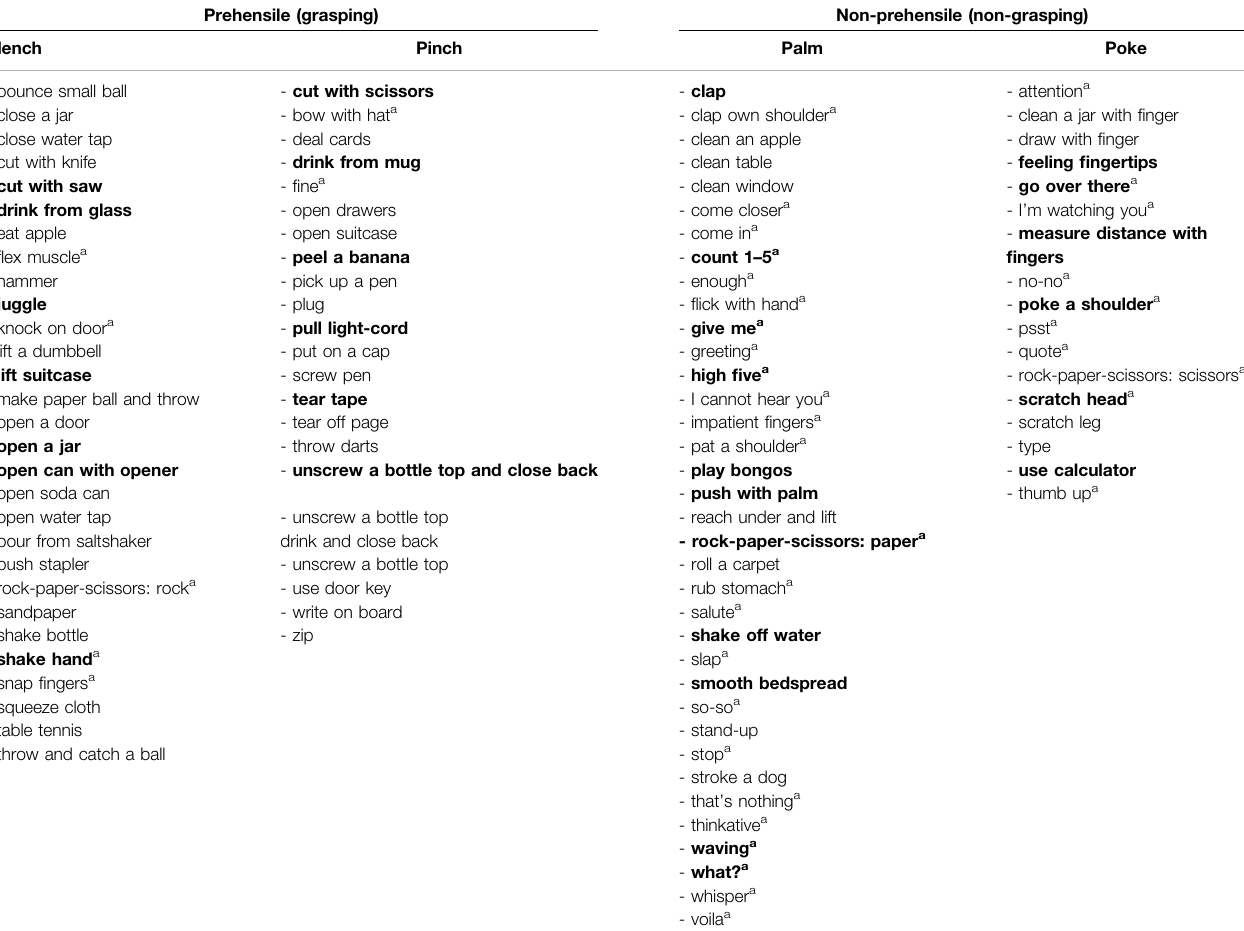
TABLE 1 | Library of gestures grouped by hand action category. Gestures rated in the experiment are in bold and social gestures have a a . Prehensile (grasping)